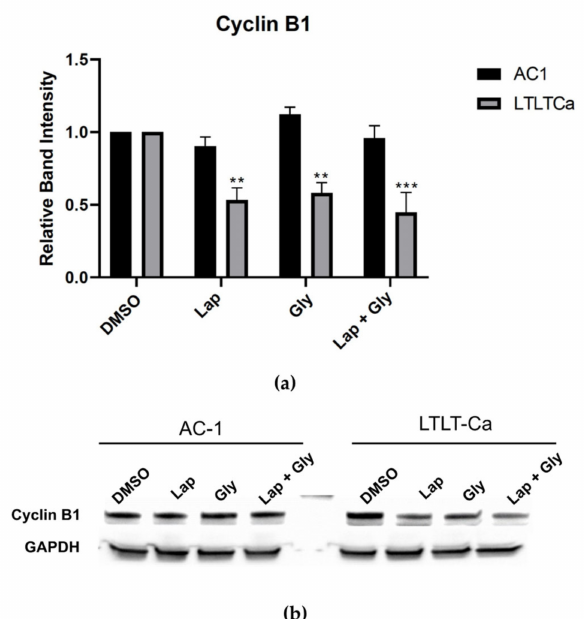
Figure 6. Lapatinib and glyceollin alters cell cycle progression mediating by cyclin B1. ( a ) The AC-1 and the LTLT-Ca cells were treated with the vehicle control (DMSO), 5 µ M lapatinib, 10 µ M glyceollin, and 5 µ M lapatinib + 10 µ M glyceollin (combo) for 24 h and assayed by immunoblot with antibodies directed against cyclin B1. GAPDH was measured as an internal loading control. Quantitative analysis representing the fold changes in cyclin B1 after normalizing to the GAPDH loading control. The AC-1 and LTLT-Ca cells were set to 100%. Two-way ANOVA analysis were performed, and treatments were compared to DMSO control. Results are expressed as the mean unit ± SD (*** p < 0.001, ** p < 0.01), and data are representative from one of at least three